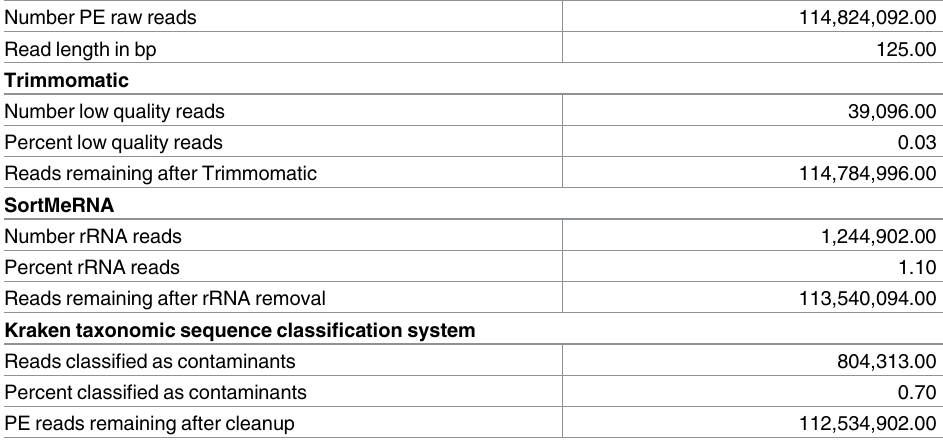
Table 1. Trimming statistics using three different filtering